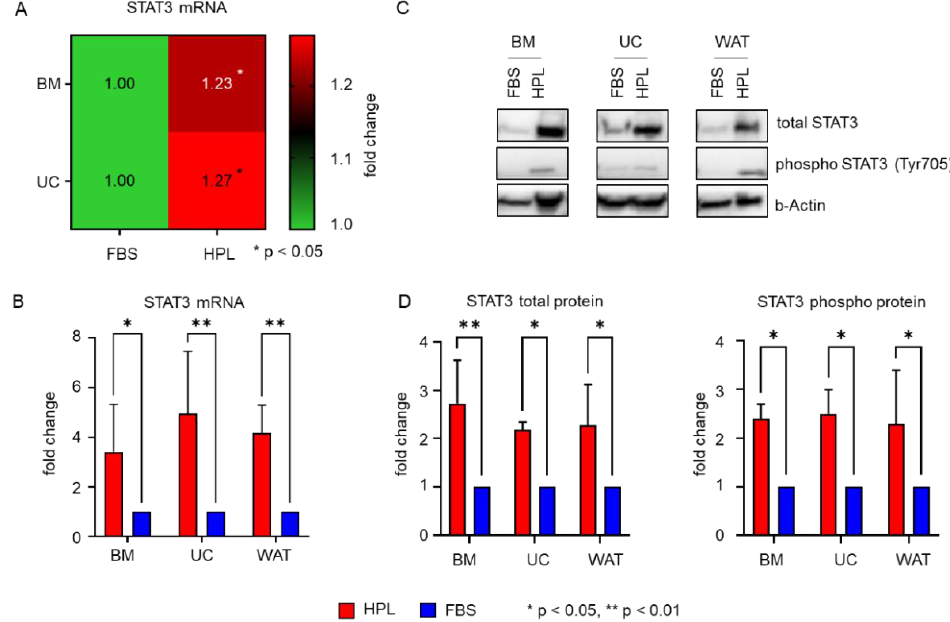
Figure 3. HPL mediates significant activation of STAT3 expression. ( A ) Heat map of genome expression profiling showing significantly enhanced expression levels of STAT3 in BM- and UC-derived stromal cells when cultured in HPL compared to FBS. Data shown are mean fold change expression values ± SD of three biological replicates measured in technical duplicates. ( B ) RT-qPCR reveals significantly elevated mRNA expression for all cell types when cultured in HPL (red bar) compared to FBS (blue bar). Data shown are mean fold change values ± SD of three biological replicates measured in duplicates. ( C ) Western blot demonstrates that STAT3 total protein and phospho-STAT3 (Tyr705) are elevated in HPL compared to FBS-culture. One representative for each cell type is shown. ( D ) Quantitative analysis of Western blots (HPL: red bars, FBS: blue bars). Data shown are mean fold change values ± SD of three biological replicates normalized to b(eta)-Actin